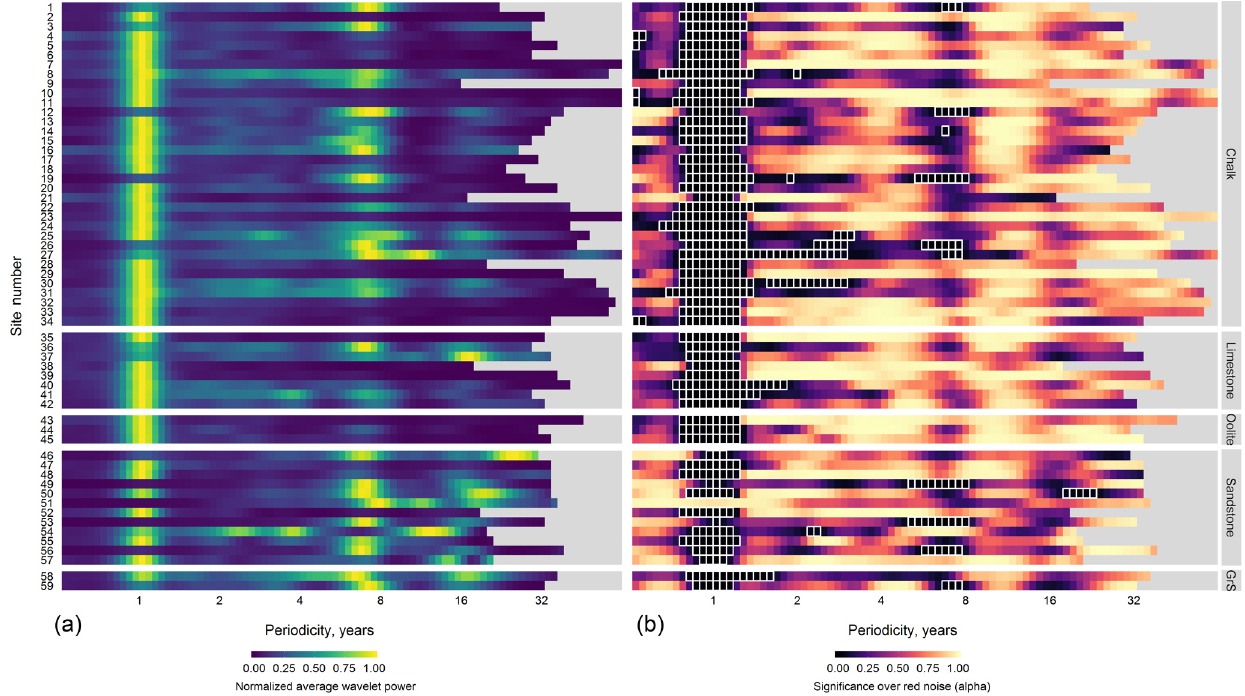
Figure 2. Normalized average wavelet power spectra (a) and wavelet power significance alphas (b) for monthly groundwater levels in the 59 index boreholes (grouped by aquifer type). In the right-hand figure, boxes outlined in white are those powers that are significant over red noise to a 95% confidence interval ( a < = 0 .